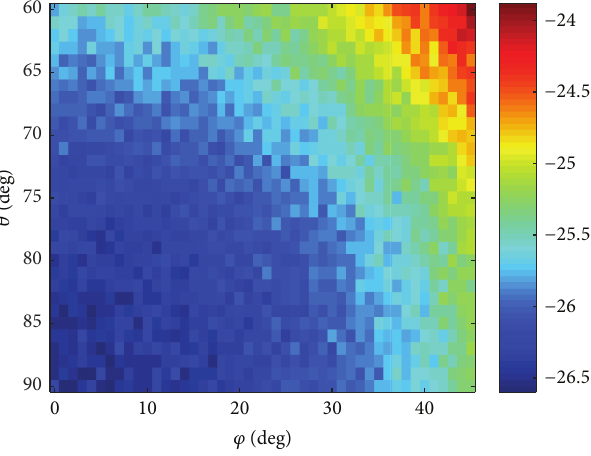
Figure 9: ICPR in dB with |𝛿 𝑖𝑗 | = 0 . 02, |𝛼 𝑖𝑗 |,|𝛽 𝑖𝑗 | ∼ 𝑈( 0 , 4 )